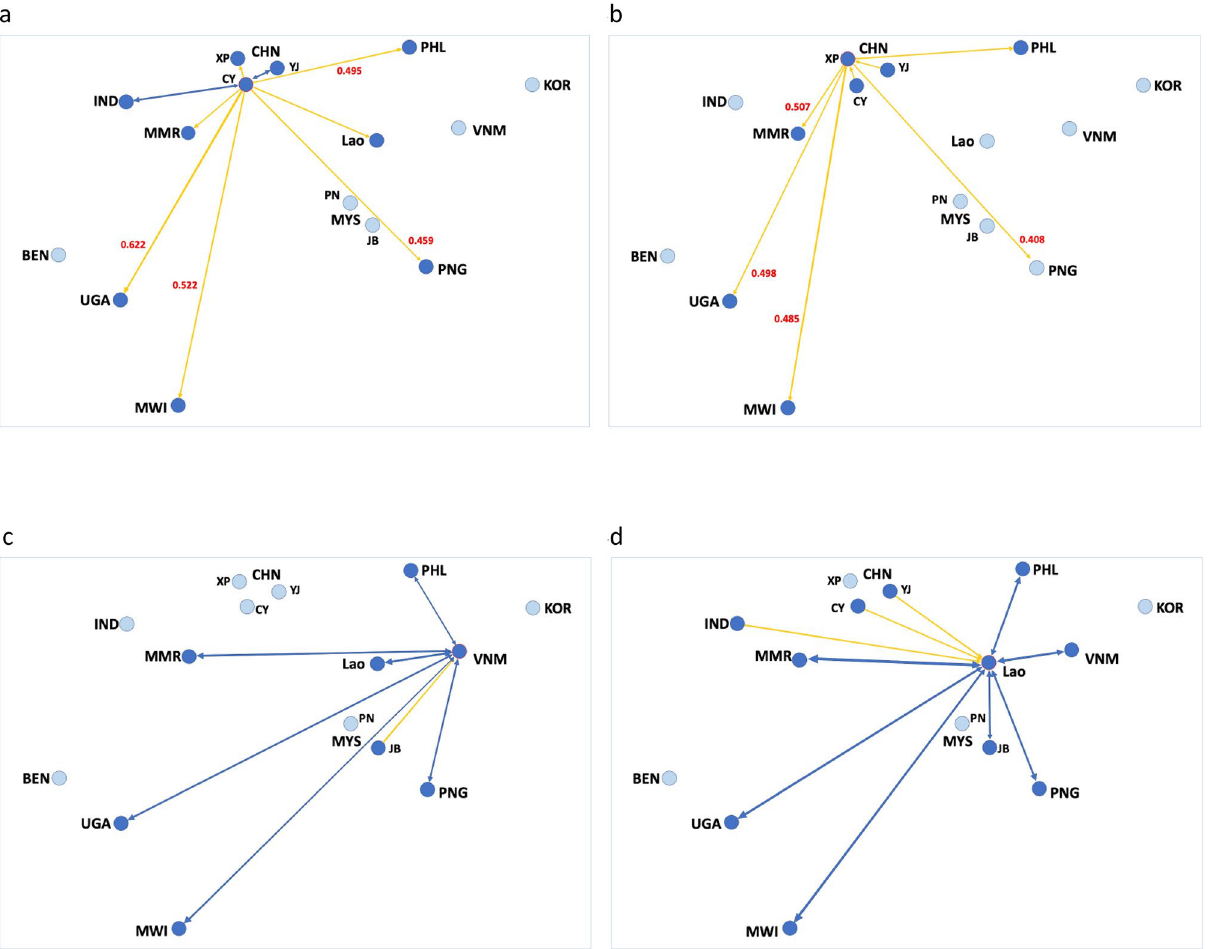
Figure 4. ( a , b ) DivMigrate analyses with edge weight setting at 0.453 showing unidirectional (yellow arrow lines) and bidirectional (blue arrow lines) gene flow between countries in Africa and South Asia/East Asia/ SE Asia. Significant migration rates (at alpha = 0.5) are in red and as provided in Table 3. Incidences of unidirectional migration were predominantly detected from China (CHN) Yunnan populations (CY, XP) to SE Asian populations (e.g., Myanmar (MMR), Laos PDR (Lao), Philippines (PHL)) and to east African populations (e.g., Uganda (UGA), Malawi (MWI)) ( a , b ). Source populations are CY ( a ) and XP ( b ). ( c , d ) DivMigrate analyses with edge weight setting at 0.453 showing unidirectional (yellow arrow lines) and bidirectional (blue arrow lines) migration between countries in Africa and South Asia/East Asia/SE Asia. Migration rates between populations are as provided in Table 3. ( c ) Vietnam (VNM) as the source population identified an incidence of unidirectional migration from Malaysia (MYS) Johor state (JB) to Vietnam, while bidirectional migration events were detected from Vietnam to other SE Asian (e.g., Philippines (PHL), Lao PDR (Lao), Myanmar (MMR)), to Pacific/Australia (i.e., Papua New Guinea (PNG)), as well as to east Africa (Uganda (UGA), Malawi (MWI)). ( d ) Lao PDR (LAO) as source population identified bidirectional migration events between various SEA populations and east African populations, while unidirectional migration events were identified from India (IND) and China (CHN) Yunnan populations (CY, YJ) to Laos PDR. No migration events were evident from SE Asian populations to